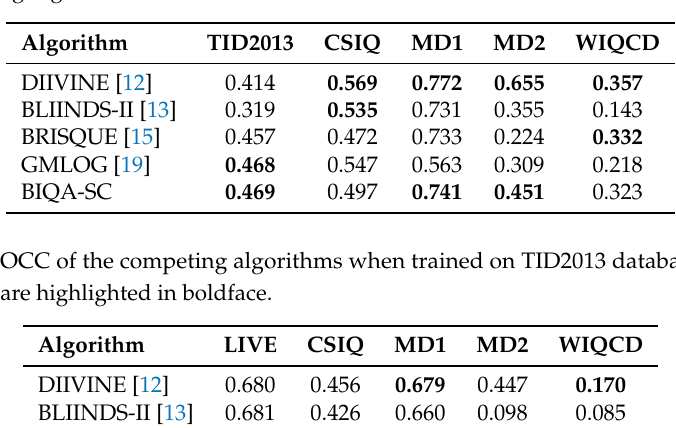
Table 7. The SROCC of the competing algorithms when trained on LIVE database [28]. The best two algorithms are highlighted in boldface.